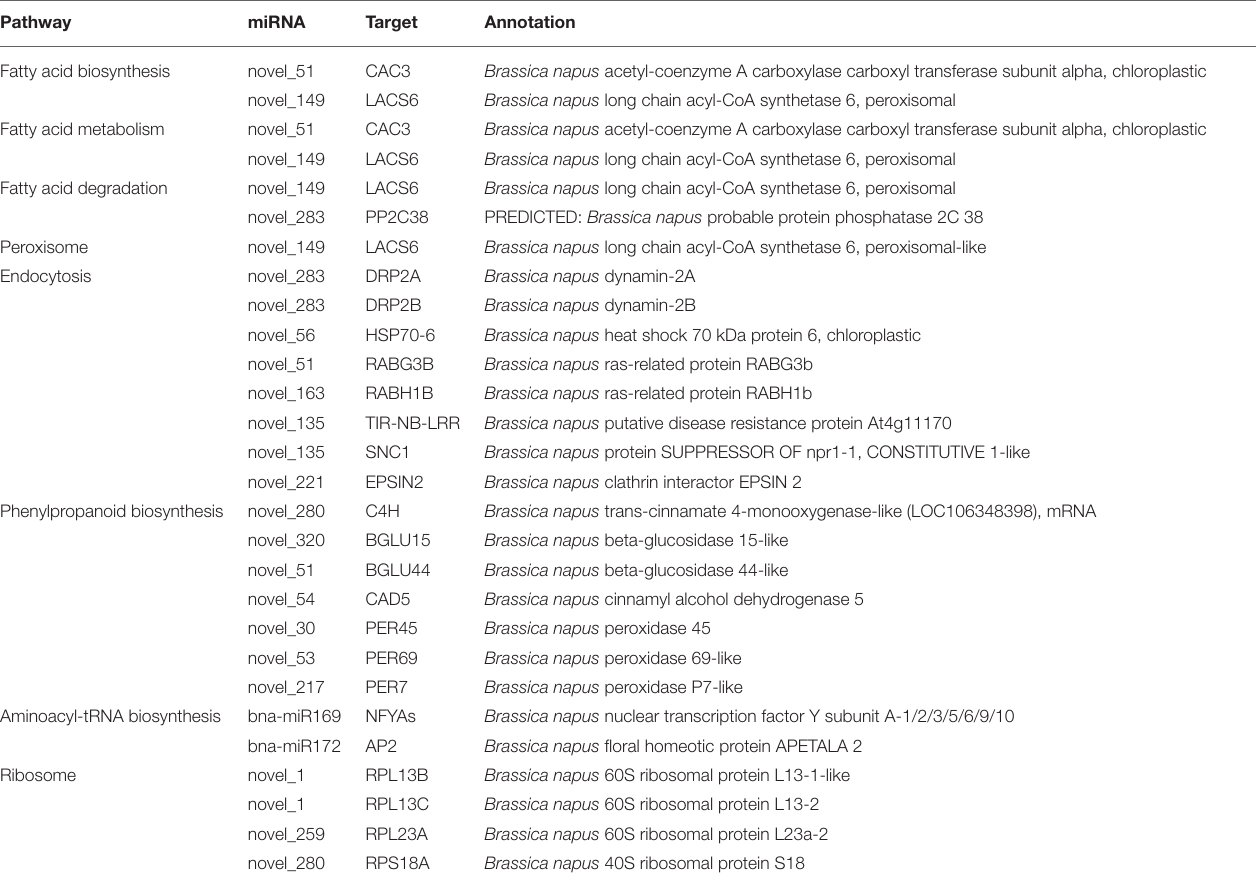
TABLE 5 | Micro ribonucleic acids and targets involved in differential enrichment pathways between resistant and susceptible materials. Pathway